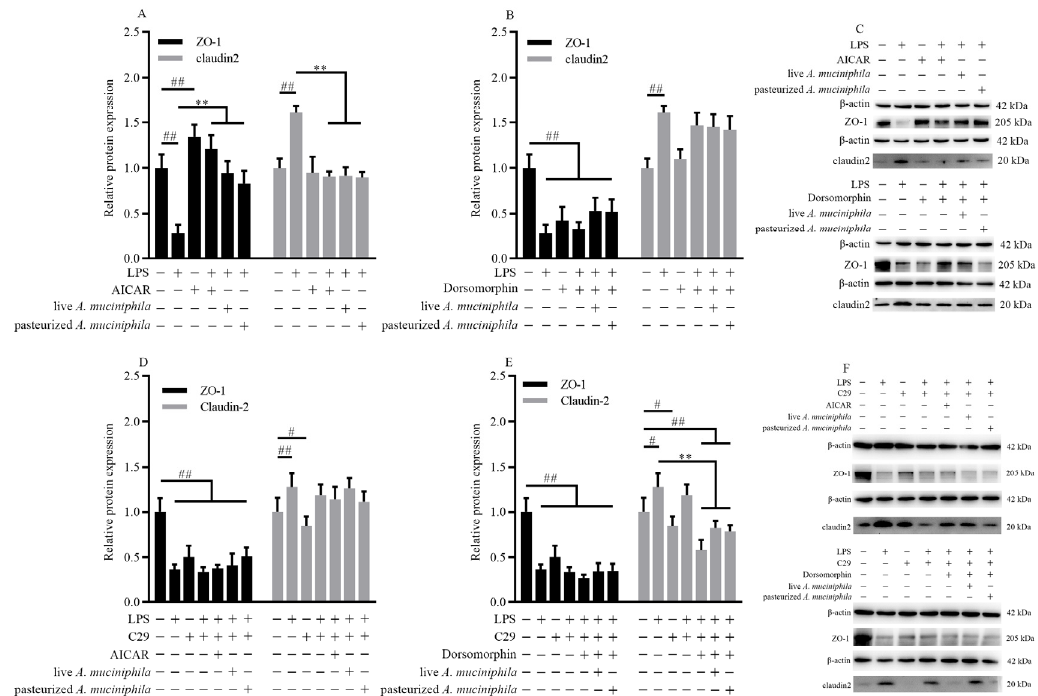
Figure 5. A. muciniphila mediated the expression of ZO-1 and claudin2 through activation of the AMPK signaling pathway dependent on TLR2 in Caco-2 cells. ( A – C ) The ZO-1 and claudin2 protein expressions were treated with AICAR or dorsomorphin in Caco-2 cells. ( D – F ) The level of ZO-1 and claudin2 treated with C29, AICAR, or dorsomorphin in Caco-2 cells induced by pretreatment with A. muciniphila . ** p < 0.01, compared with LPS group; ## p < 0.01, # p < 0.05, compared with NC group. Data are expressed as mean ± S.D. ( n = 6). LPS, lipopolysaccharide. AICAR, 5-Aminoimidazole-4- carboxamide ribonucleotide. C29, C16H15NO4. ZO, zonula occludens.